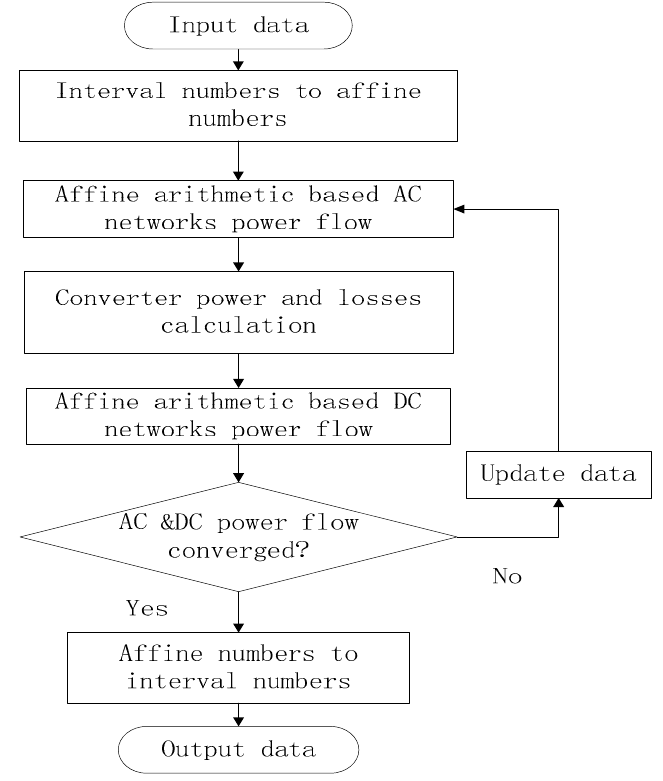
Figure 5. Flow chart of affine-arithmetic-based AC/DC power flow.